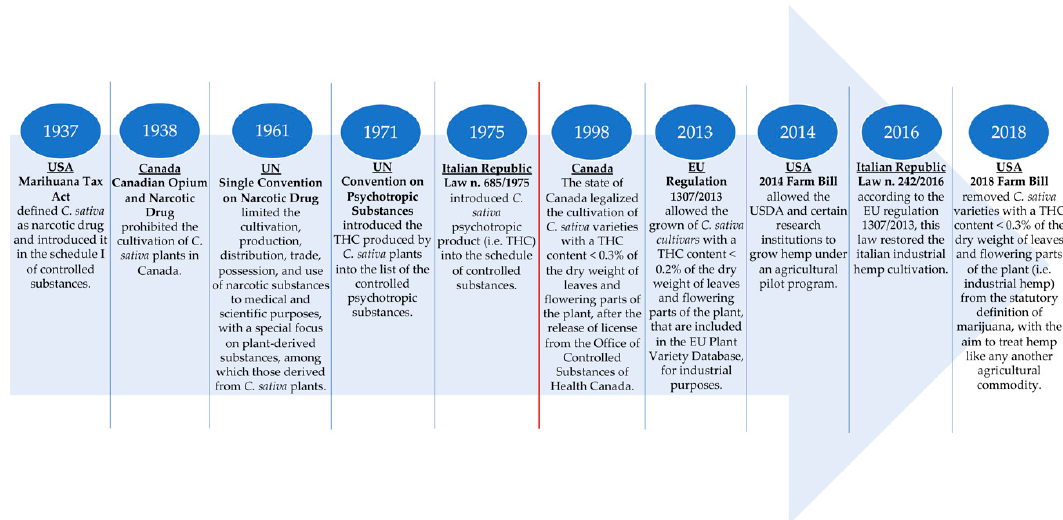
Figure 3. The main points of the legislation about C. sativa L. (industrial hemp) cultivation in the US, Canada, and the EU with a focus on the Italian Republic among the EU states. The red line separates the legislation related to the prohibition of C. sativa L. cultivation (left part of the red line) from that allowed the reintroduction of growing of this crop (right part of the red line). For more details, see Section 2.3. US: United States; UN: United Nations; THC: delta-9-tetrahydrocannabinol; EU: European Union; USDA: United Stated Department of Agricultural.